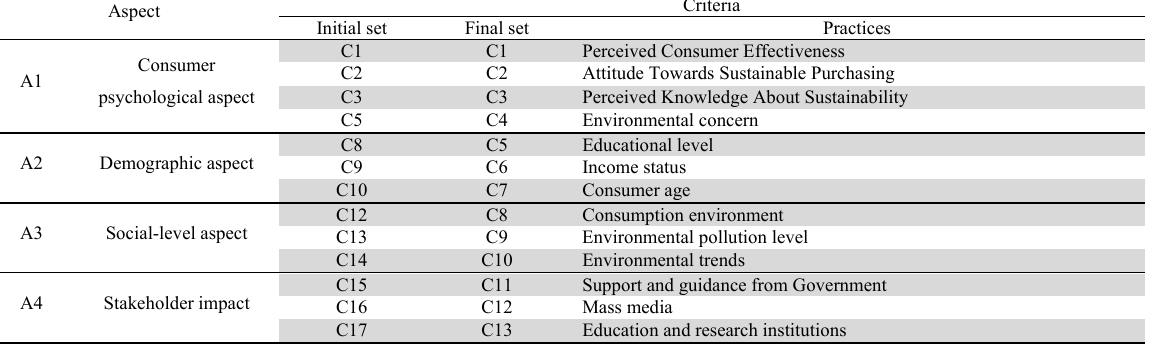
FDM result for aspects and